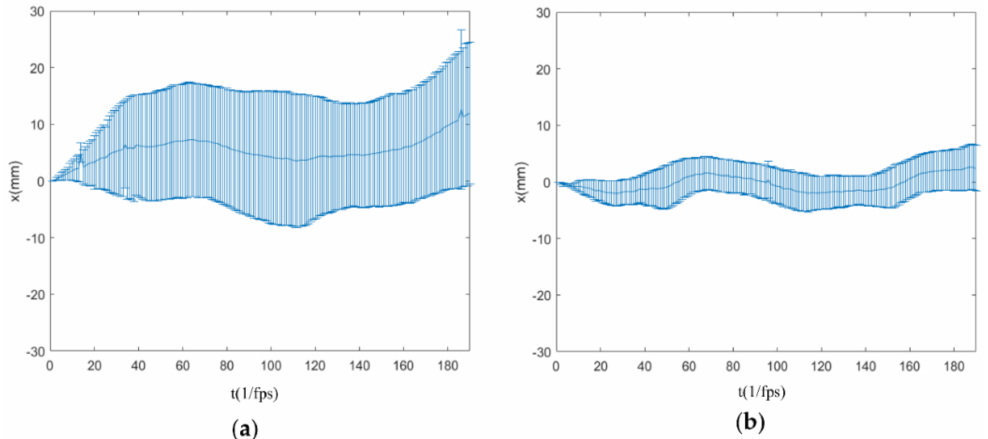
Figure 12. The x-component, perpendicular to the rolling direction, of COM trajectory of the ball in each leg motion loop. The solid line indicates the average value of each time, and the error bar indicates the standard deviation of each time; ( a ) 40 ◦ –70 ◦ rolling range; and ( b ) 50 ◦ –80 ◦ rolling